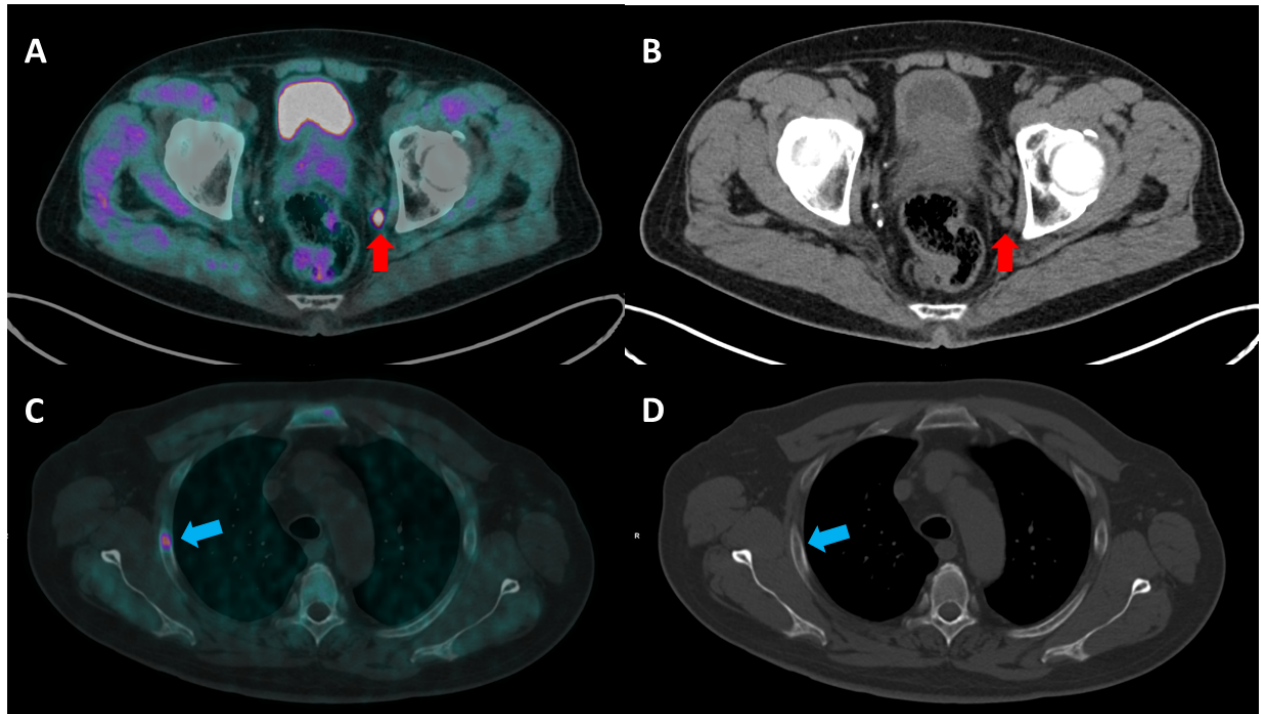
Figure 2. ( A , B ) A 71-year-old man with locally advanced PCa (Gleason score 9, 4 + 5 and a serum PSA value of 36 ng/mL) underwent [ 18 F]F-choline PET/CT (( A ) transaxial fused image; ( B ) CT image) for the initial staging of the disease. The PET/CT image shows a pathological uptake corresponding to a small left internal iliac lymph node (red arrow). Lymph node metastasis was not detected in CT staging, as its size (0.7 × 0.6 mm) was below the significance criteria. ( C , D ) A 68 year-old-man with PCa (G.S 6, 3 + 3; PSA value of 71.29 ng/mL) was imaged with [ 18 F]F-choline PET/CT staging (( C ) transaxial fused image; ( D ) CT image), with evidence of a focal uptake corresponding to a bone lesion at the third right rib (blue arrow), which could not be detected by CT due to the normal bone structure.